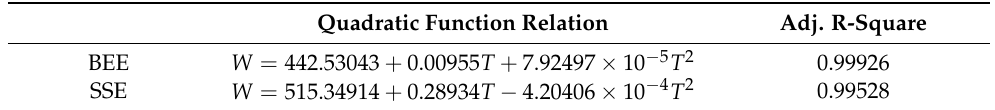
Table 3. Temperature dependence of the PL peak wavelength of the Ag@SiO 2 @CdS/ZnS composite nanoparticle film sensor.